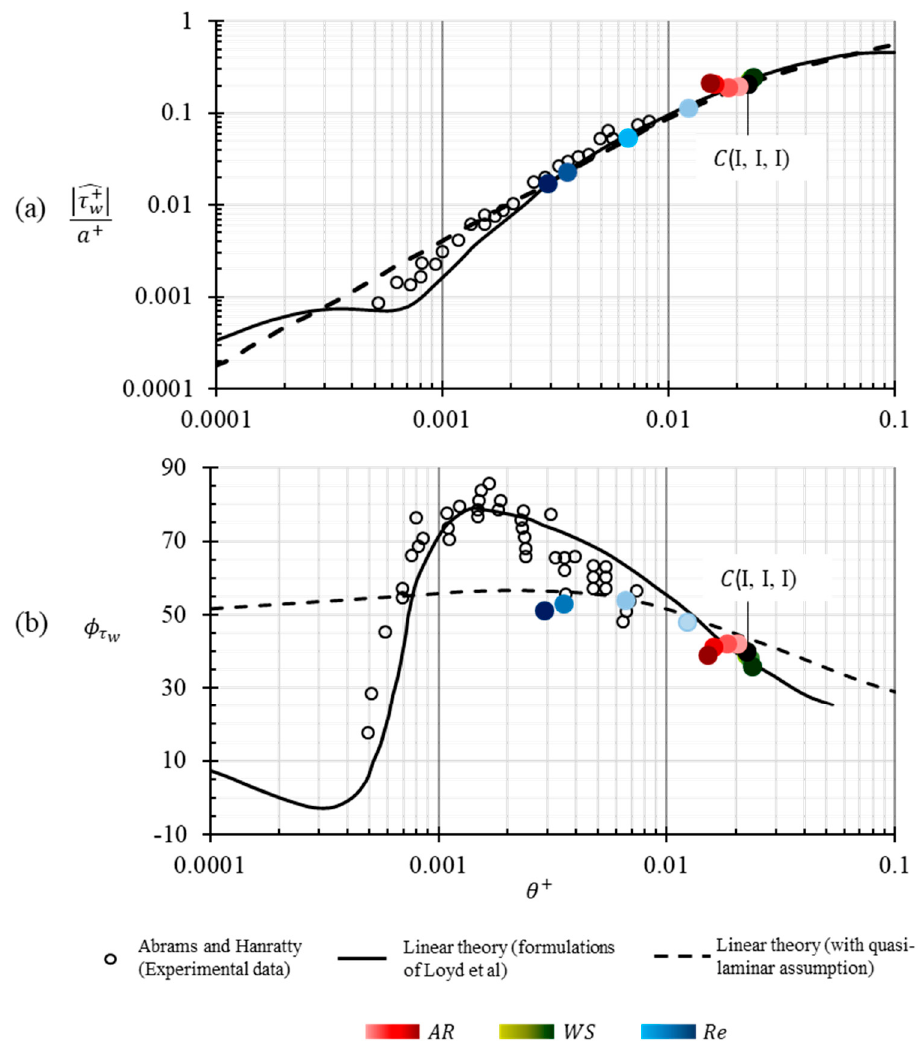
Figure 4. Comparison of theory and experimental data with current study for; ( a ) normalized non-dimensional shear amplitude on the bottom wall, and ( b ) phase-shift of shear stress on the bottom wall, plotted against non-dimensional wave number. All color-coded data is from the current study. Experimental data, linear theory formulations of Loyd et al., and linear theory with quasi laminar assumption is reproduced from Abrams and Hanratty [6].